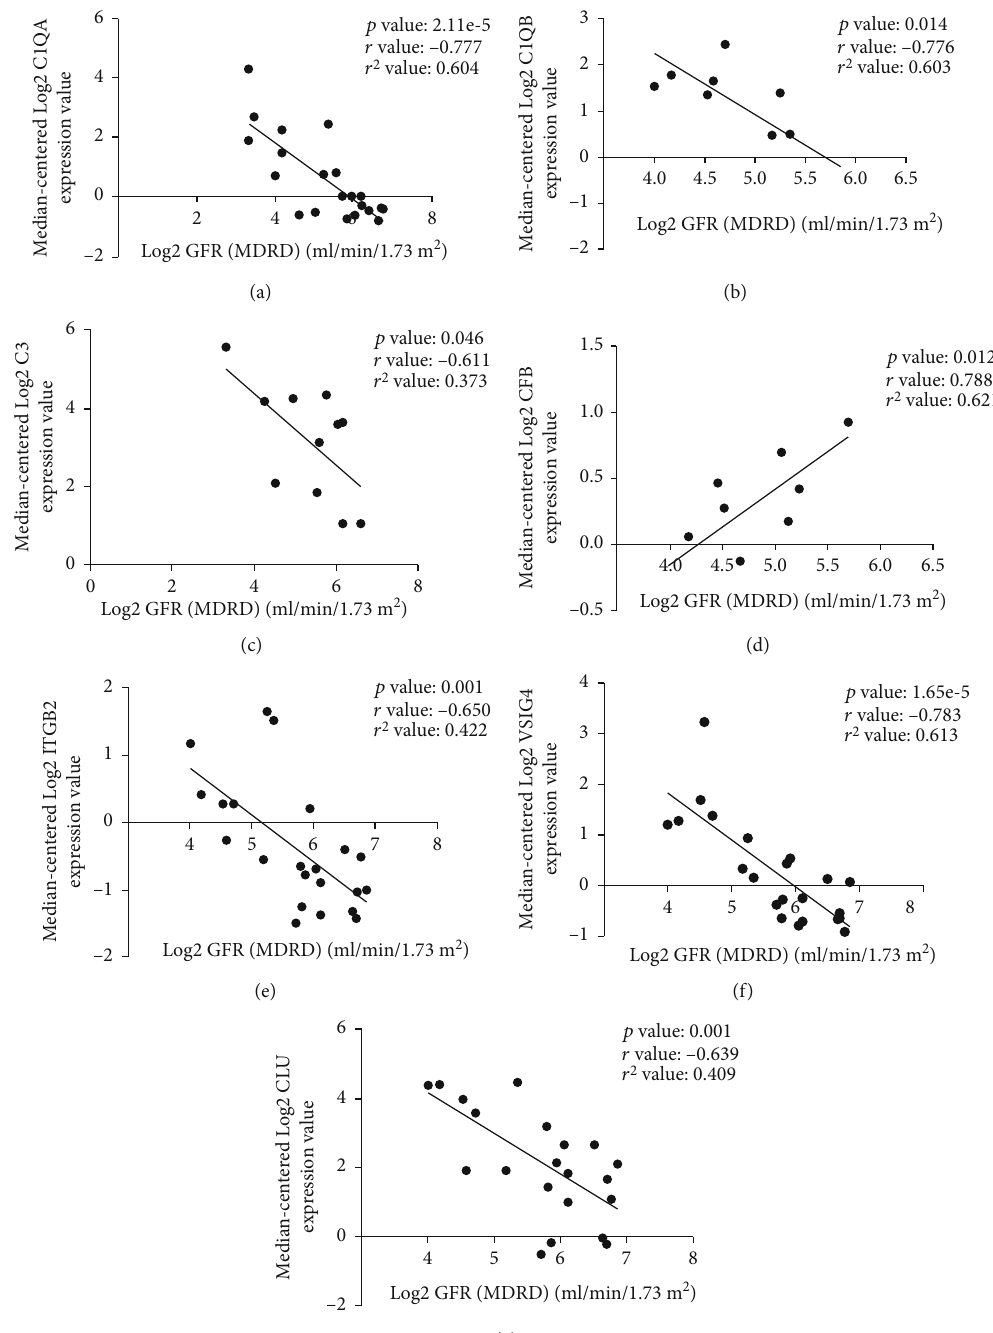
Figure 10: The correlation analysis between complement cascade-related hub genes (C1QA, C1QB, C3, CFB, ITGB2, VSIG4, and CLU) and the expression of GFR in DN patients. (a) The expression of C1QA was negatively correlated with GFR ( P < 0 : 001 , r = – 0 : 777 ). (b) The expression of C1QB was negatively correlated with GFR ( P = 0 : 014 , r = – 0 : 776 ). (c) The expression of C3 was negatively correlated with GFR ( P = 0 : 046 , r = – 0 : 611 ). (d) The expression of CFB was positively correlated with GFR ( P = 0 : 012 , r = 0 : 788 ). (e) The expression of ITGB2 was negatively correlated with GFR ( P = 0 : 001 , r = – 0 : 650 ). (f) The expression of VSIG4 was negatively correlated with GFR ( P < 0 : 001 , r = – 0 : 783 ). (g) The expression of CLU was negatively correlated with GFR ( P = 0 : 001 , r = – 0 : 639